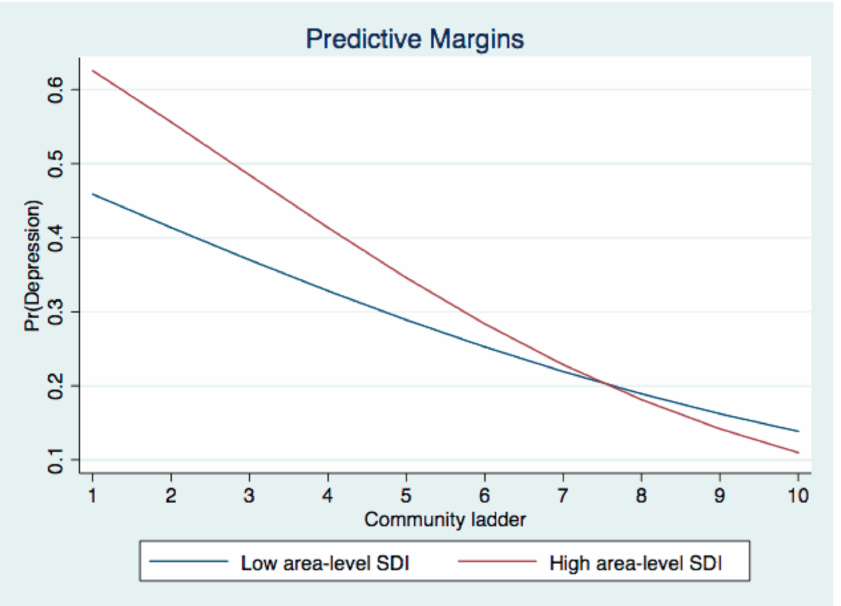
Figure 2. Interactive effect between community ladder and area-level SDI on depression among women. Additionally, the interaction between perceived status in the community and area-level social deprivation was significant for grip strength among women (Model 2c: logit = − 0.23, 95%CI = [ − 0.43, − 0.02], p < 0.05). The simple slope analysis revealed that perceived status in the community was only positively associated with grip strength among women living in districts with lower social deprivation (Figure 3).